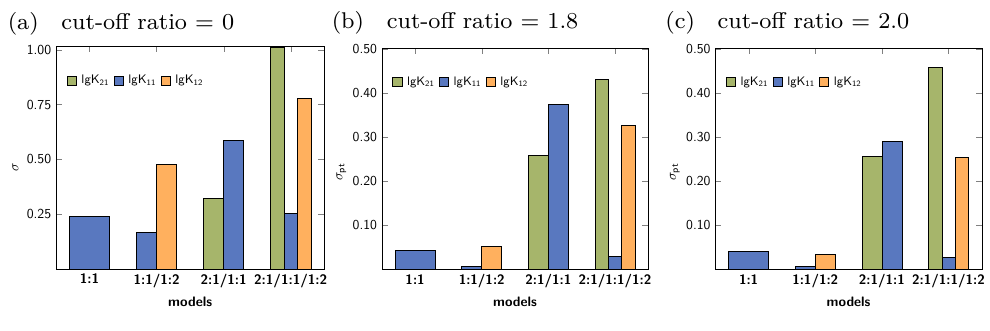
Figure 8 (A–C) The comparison of the individual σ pt values shows the good performance of the 1:1/1:2 model. In the 2:1/1:1/1:2 model , even the correct lg K 12 , that is connected to acceptable results in the Monte Carlo simulation, has higher σ pt values compared to those obtained for the correct model. The analysis applied to incorrect parameter lead to larger σ pt values in